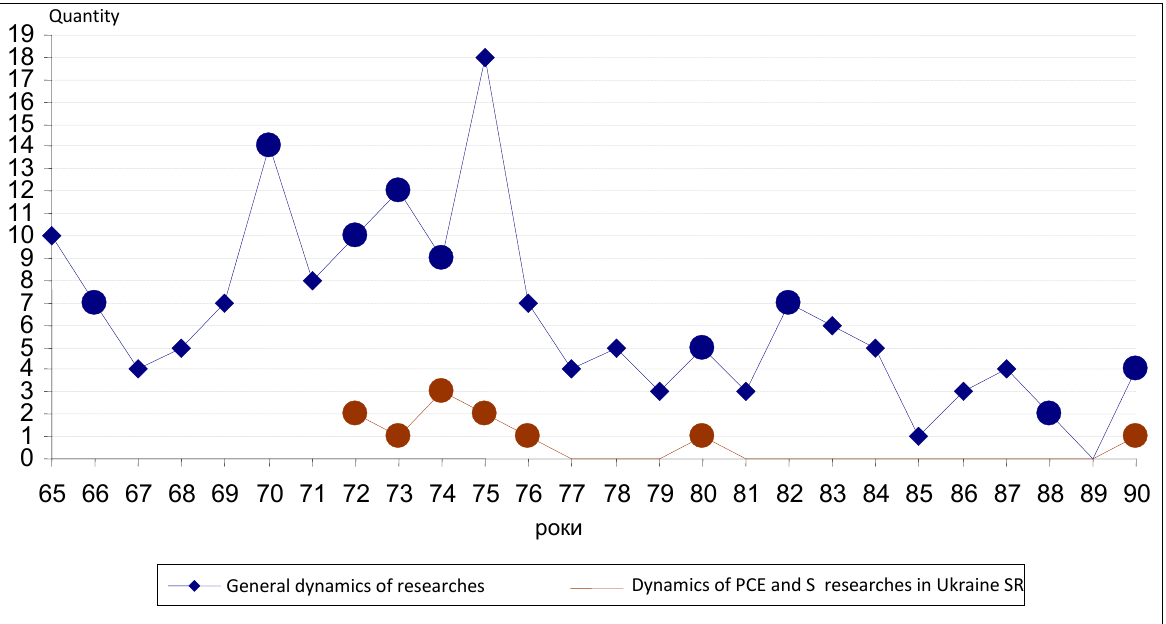
Fig3. Dynamics of dissertation researches